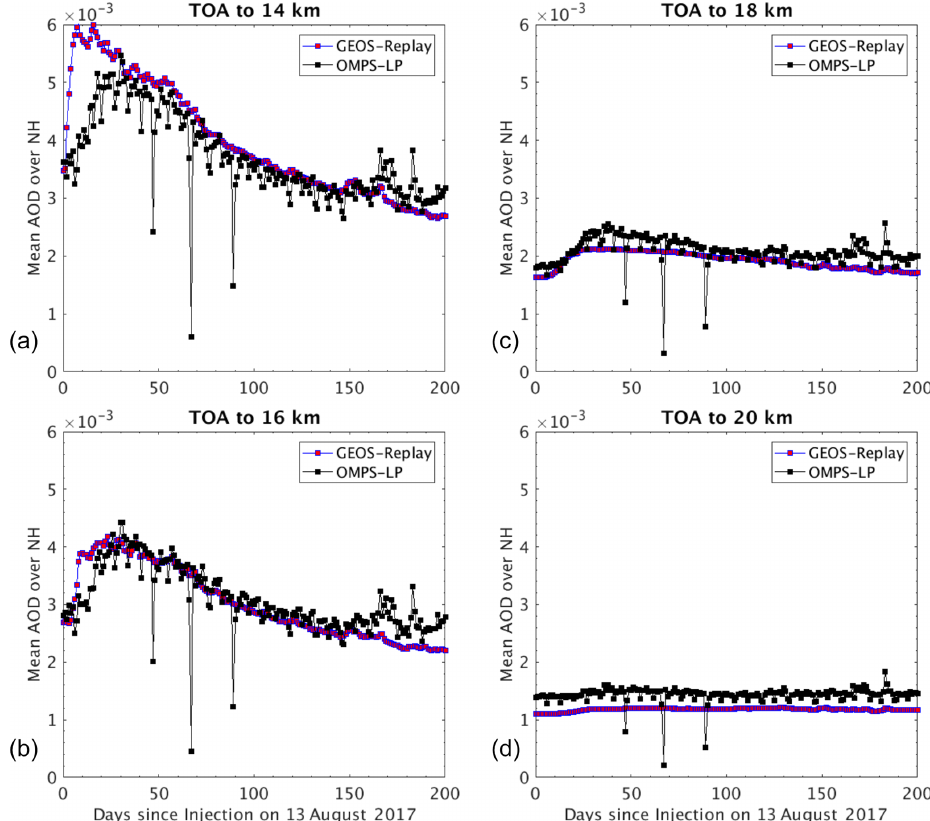
Figure 10. Vertical distribution of stratospheric aerosols containing pyroCb smoke. Time series of total AOD derived from OMPS-LP (black) and the GEOS model (magenta), averaged over the Northern Hemisphere for atmospheric columns extending from the top of the atmosphere (TOA) to (a) 14km, (b) 16km, (c) 20km and textbf(d)